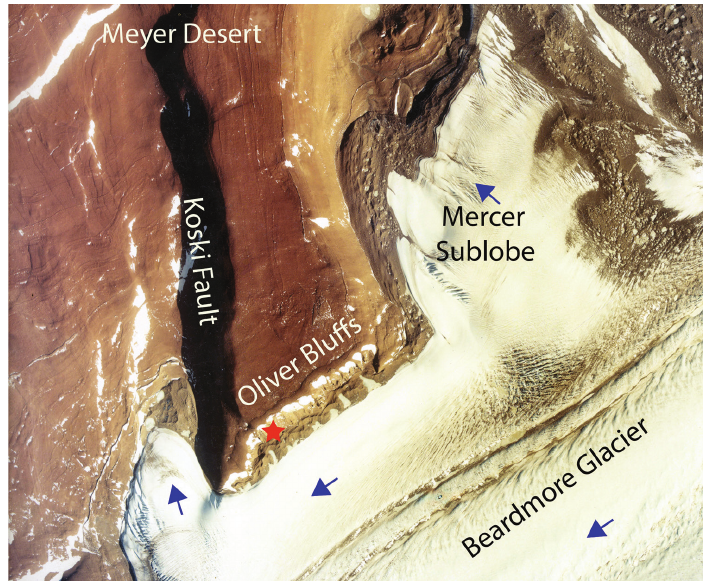
Figure 2. An aerial view of the Oliver Bluffs on the Beardmore Glacier. Ice flow directions are shown by the blue arrows. The Meyer Desert Formation is downthrown to the north along the Koski Fault. The type locality for A.balli sp. n. is shown by a red star. The aerial image # TMA-2738-4 is from the collections of the The United States Antarctic Resource Center (USARC), USGS, Reston,